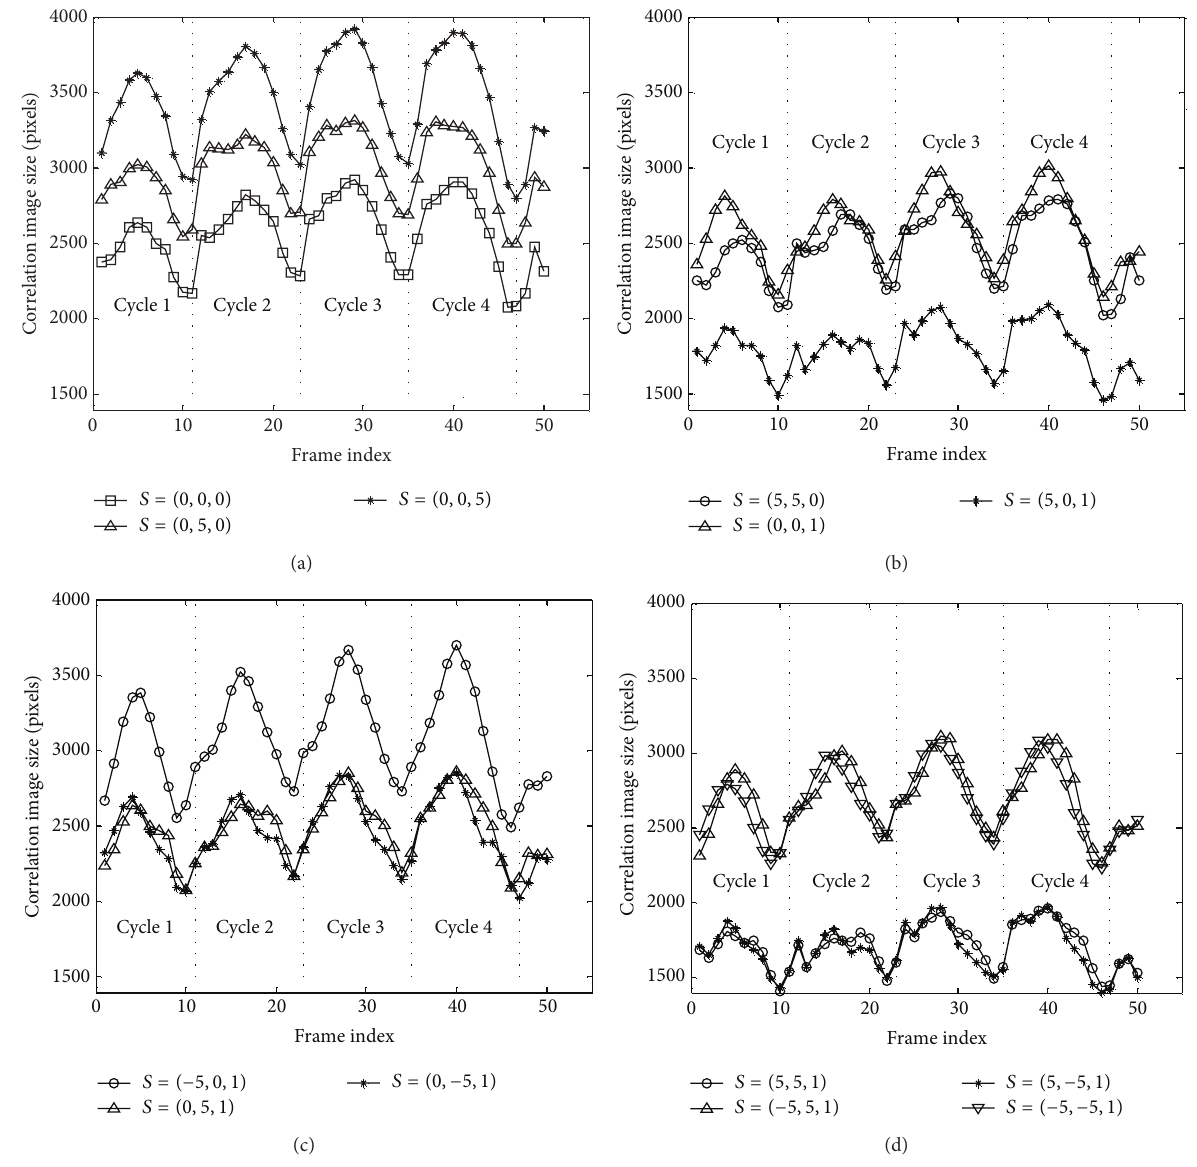
Figure 6: The 13 feature curves ( Δ𝑥 = 5 , Δ𝑦 = 5 , Δ𝑡 = 1